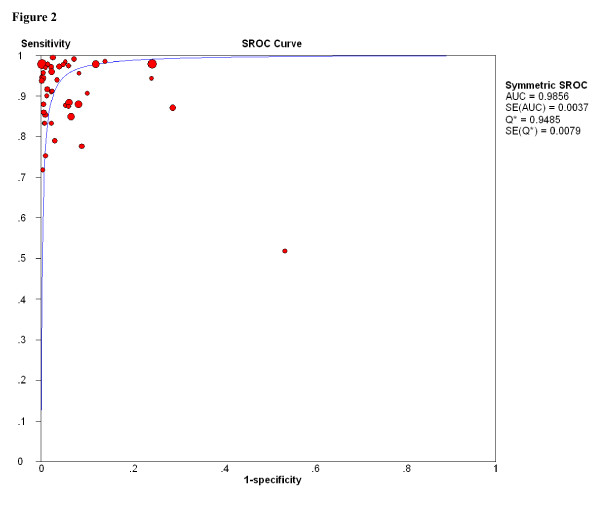
SROC curves for FANB (C1 was temporarily exluded). Each study is represented by each solid circle in the meta-analysis. The size of the solid circle indicates the size of each study. SROC curves summarize the overall diagnostic accuracy.